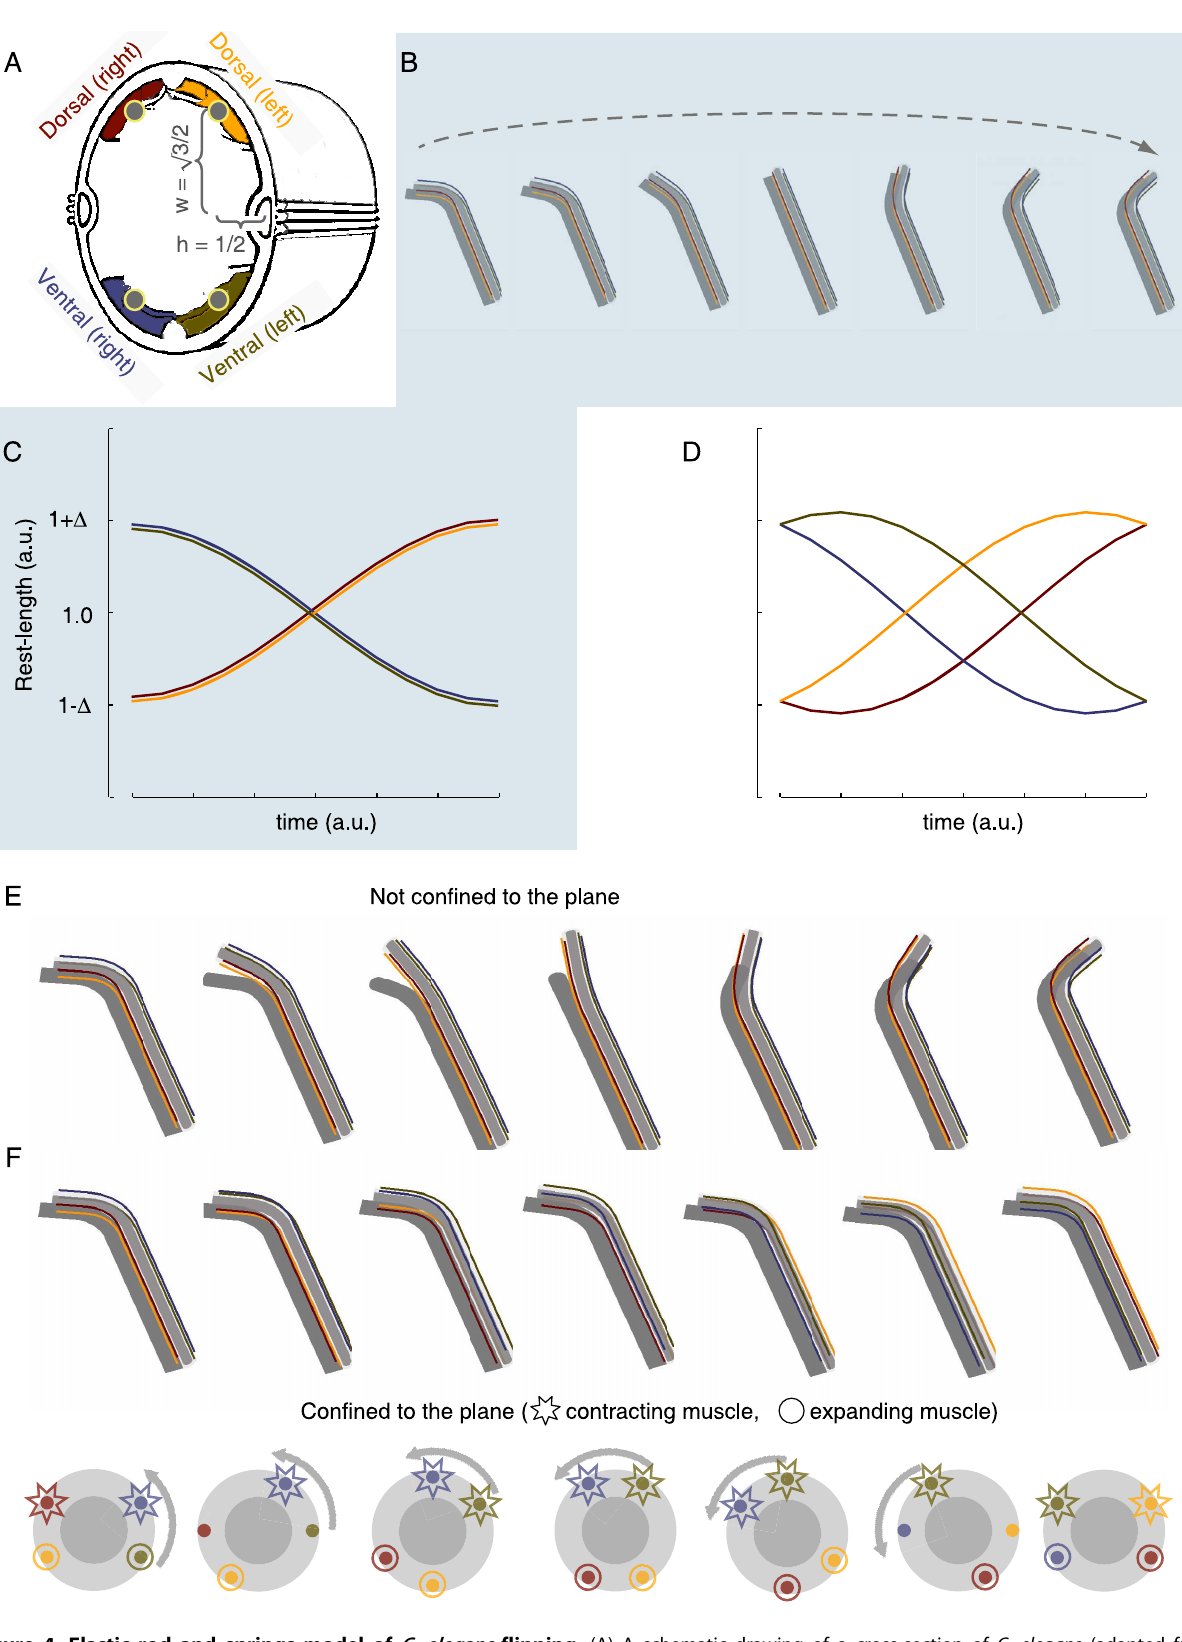
Figure 4. Elastic rod and springs model of C.elegans flipping. (A) A schematic drawing of a cross-section of C. elegans (adapted from wormatlas.org). The blue/green (ventral) and red/yellow (dorsal) areas denote the cross sections of the four muscle groups. The grey circles located at the center of the muscles denote the positions of the springs that were used in the model (where each row of springs corresponded to a